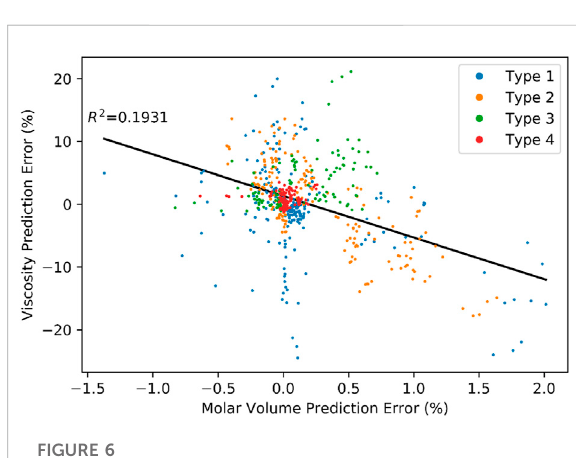
FIGURE 6 Viscosity and molar volume prediction error